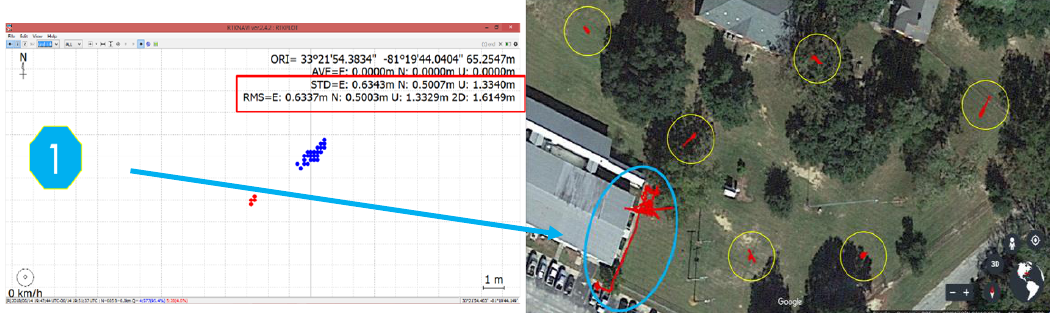
Figure 13. Results of GPS accuracy measurements.